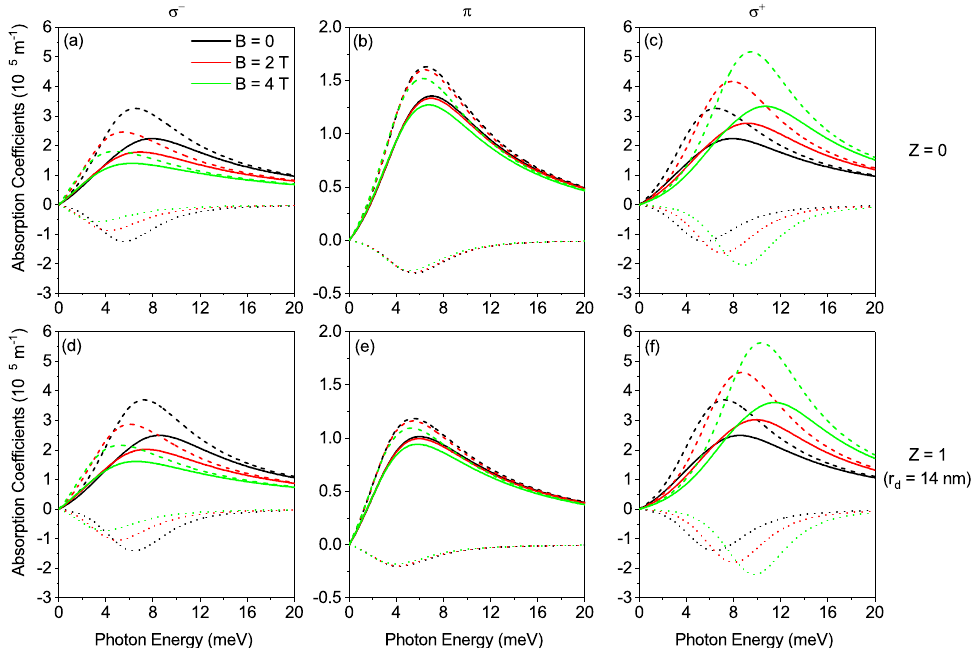
Figure 4. Plot of optical absorption coefficients as a function of the photon energy for σ ± ( Z = 0 ) , σ ± ( Z = 1 ) , π ( Z = 0 ) and π ( Z = 1 ) transitions and varying MF ( a – f ). The dashed, doted and solid curves represent linear, third-order nonlinear and total optical absorption coefficients respectively.